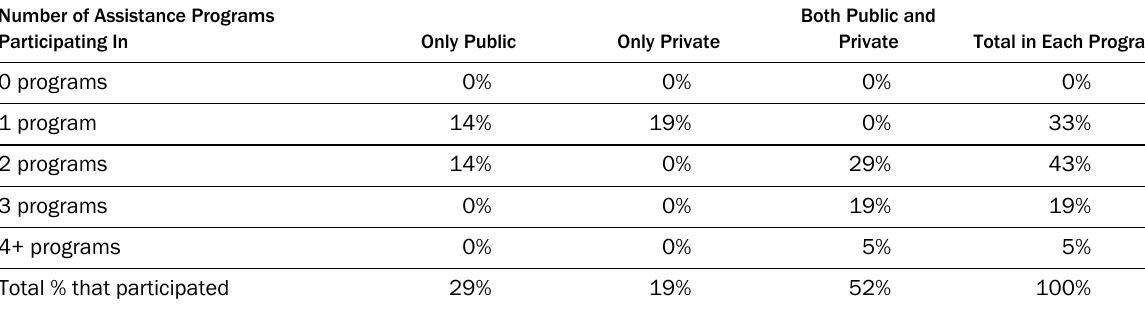
Table 3. Overall Participation Rates in Each Type of Program ( n =21) Number of Assistance